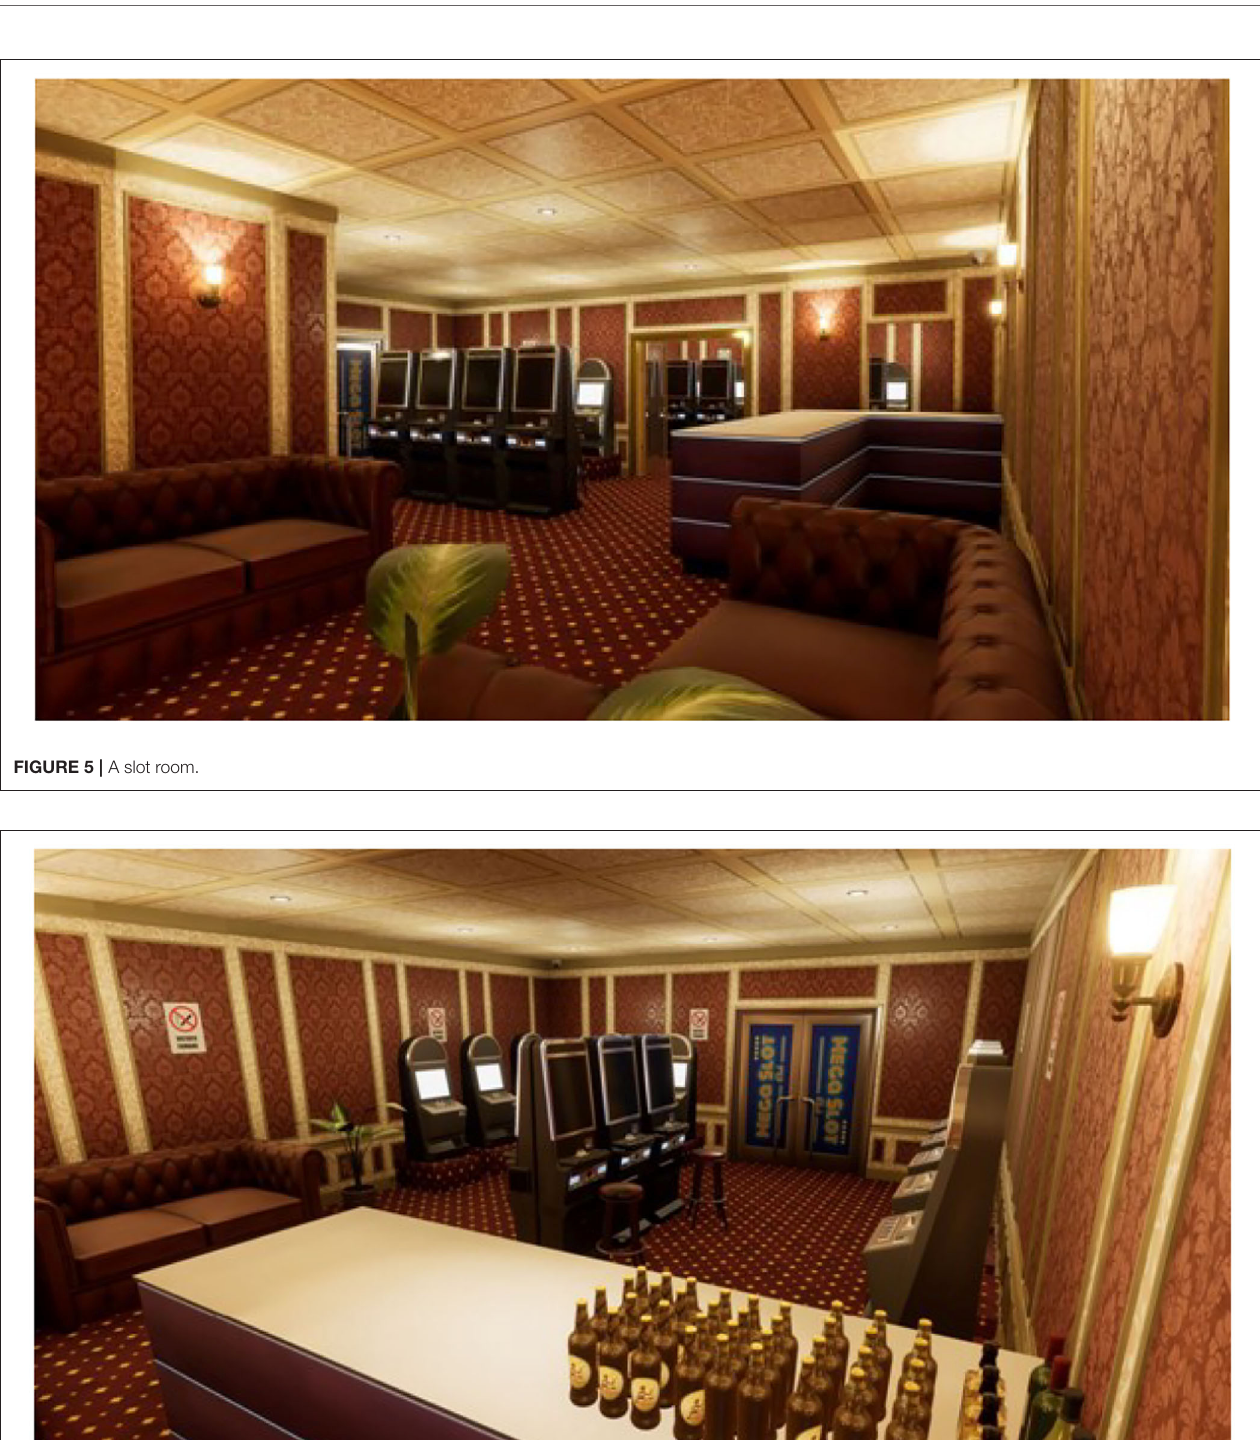
parameter recording, and the integration of software that allows the therapist to configure the settings of the experience